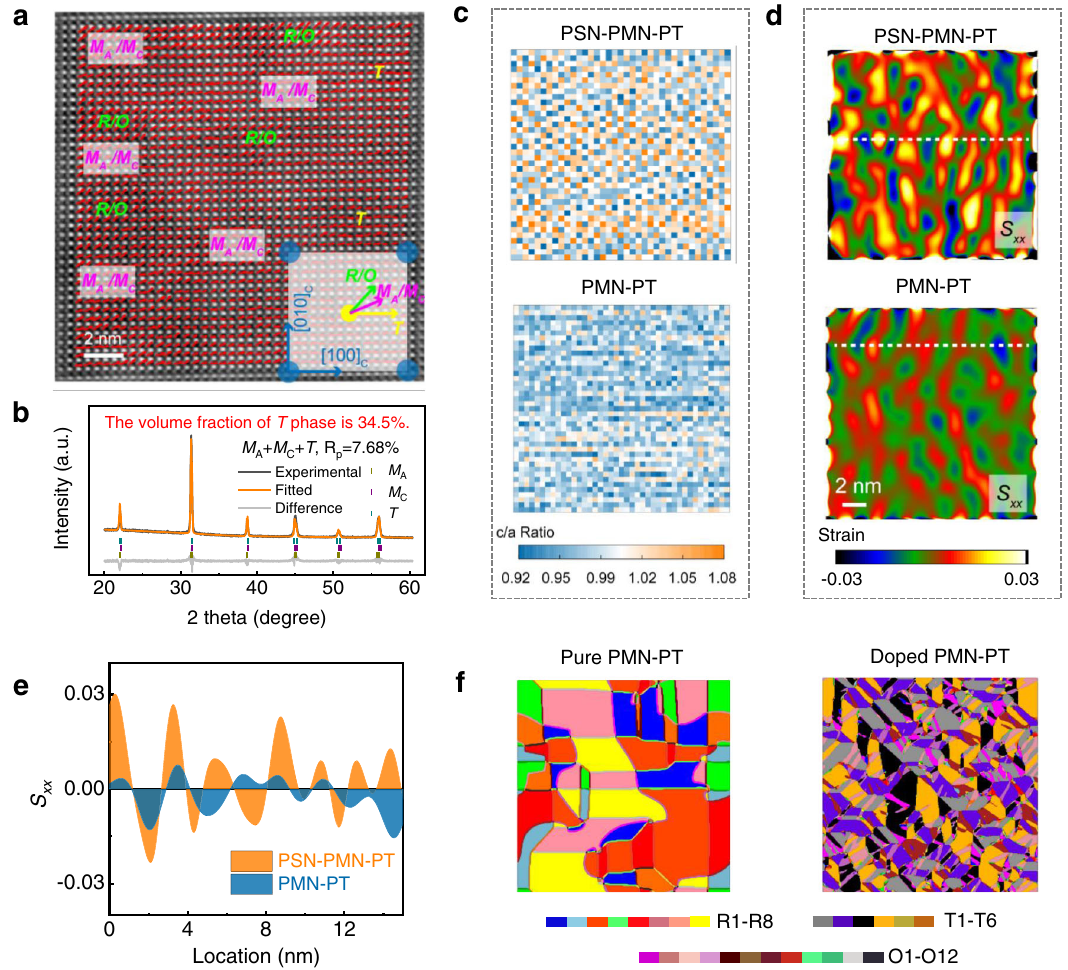
Fig. 4 Microstructure. a Atomic-resolution TEM images of the [001] C -oriented 0.06PSN – 0.61PMN – 0.33PT crystals, where the P S directions are given for each unit-cell column. The possible phase structures can be deduced using the P S directions (R rhombohedra, O orthorhombic, M A /M C monoclinic, and T tetragonal). b High-resolution XRD pattern and the optimal re fi nement results for 0.06PSN – 0.61PMN – 0.33PT. c Unit cell c / a ratios for 0.06PSN – 0.61PMN – 0.33PT and 0.67PMN – 0.33PT derived from the TEM characterizations. d Local strain S xx mapping extracted from the HAADF-STEM lattice image of 0.06PSN – 0.61PMN – 0.33PT in ( a ) and 0.67PMN – 0.33PT in Fig. S9 via GPA, and the data along the white dotted lines are extracted and shown in ( e ). f Phase- fi eld simulations of the domain structures of pure PMN – PT and that doped with tetragonal phase. PMN – PT exhibits pure R characteristics; after the introduction of the tetragonal phase, it exhibits multi-phase including R, O, and T characteristic with a reduced domain size. Different phases and various P S directions in the same phase are denoted by different